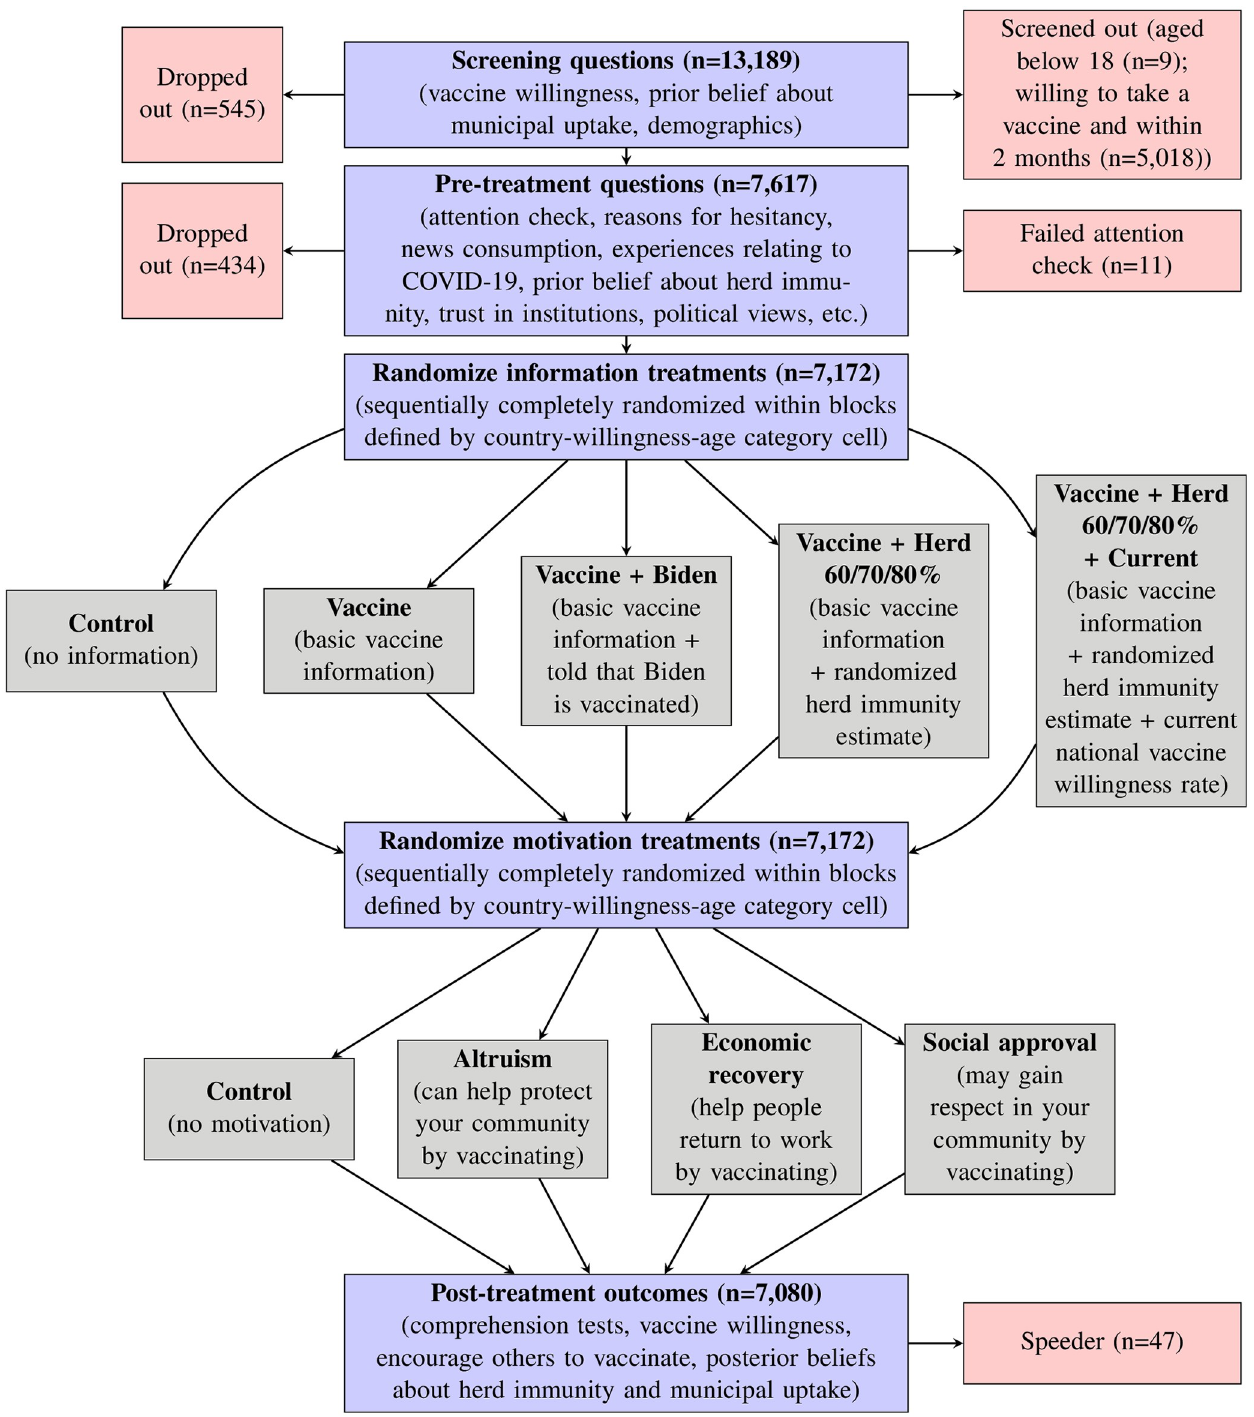
Fig 1. Overview of survey flow and treatment assignments. The n refers to the number of respondents that reach a given box. The full survey questionnaire is included in S18 Appendix.